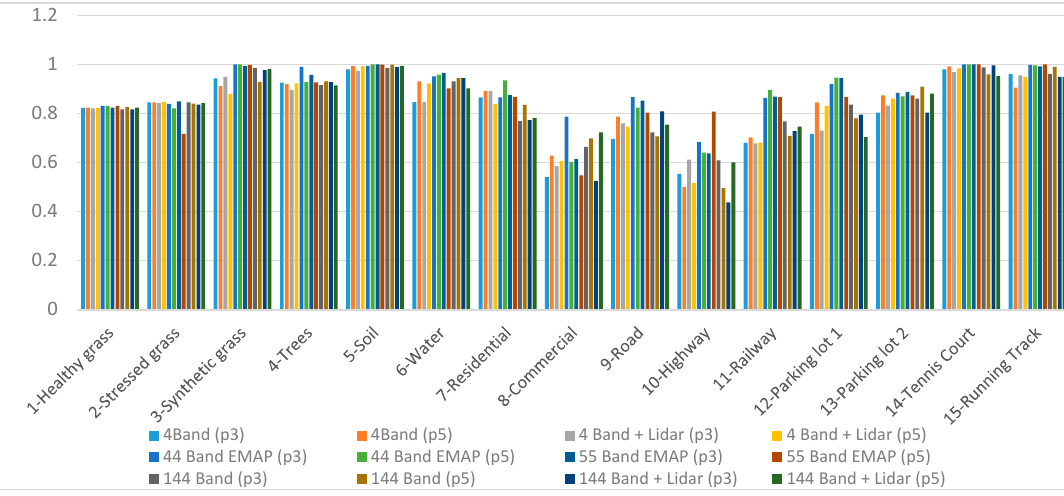
Figure 5. Classification accuracy for each land cover type with our customized CNN model using the investigated band combinations.